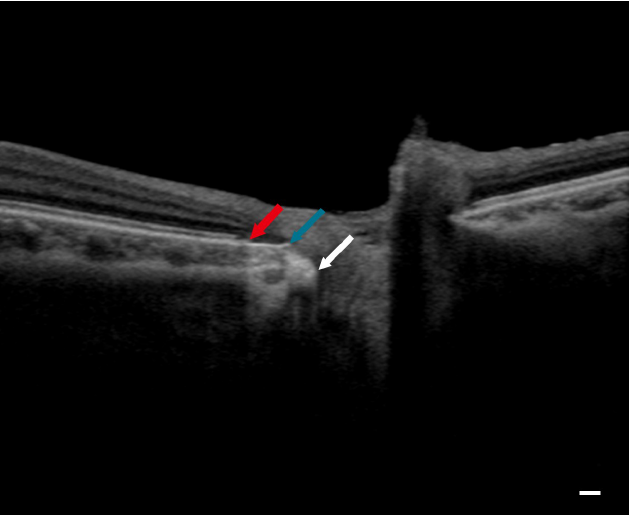
Fig 1. Identification of the beta zone and the gamma zone in a B-scan image. Scleral canal opening (white arrow), the edge of Bruch’s membrane(blue arrow), and the edge of the retinal pigment epithelium (red arrow) can be identifiedin a B-scan. A region betweenthe terminationof the retinal pigment epitheliumand the termination of Bruch’s membraneis the beta zone, and a regionbetweenthe termination of Bruch’s membraneand the scleral canal opening is the gamma zone. Scale bar = 200 μ